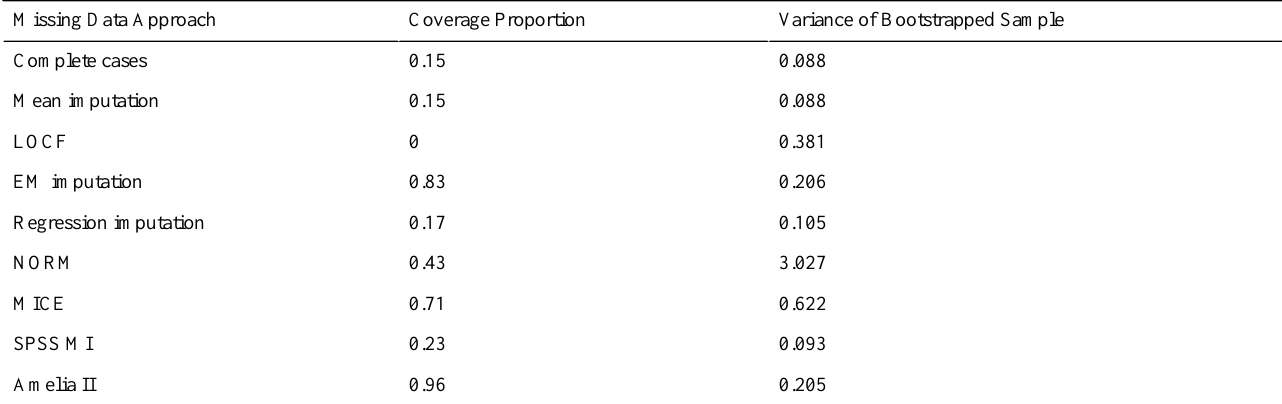
Table 3. Coverage of the reference confidence interval for imputed means